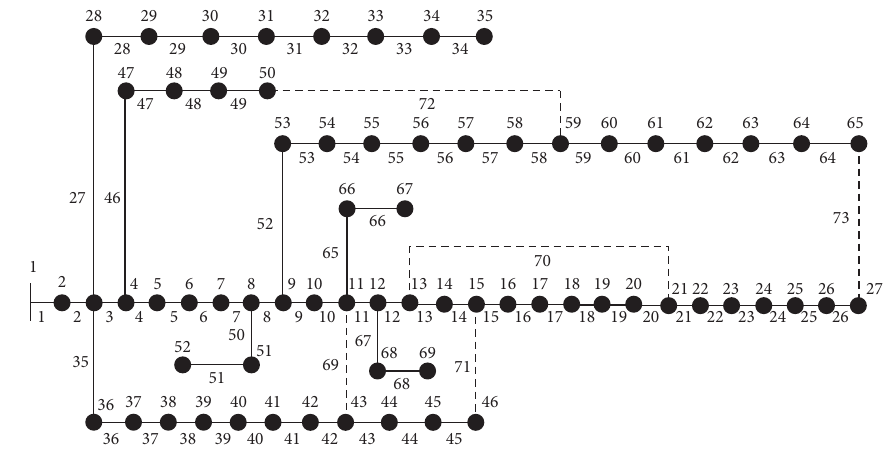
Figure 5: Te 69-node system. Table 2: Comparisons of ISOS and other techniques in solving 69-node